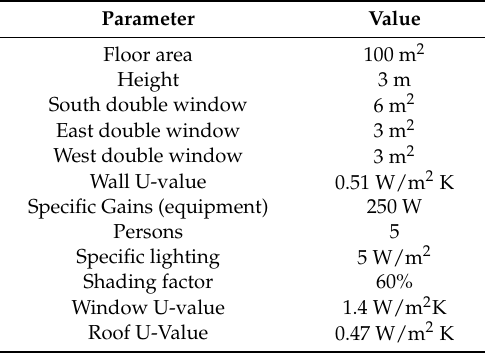
Table 1. Building parameters [25].